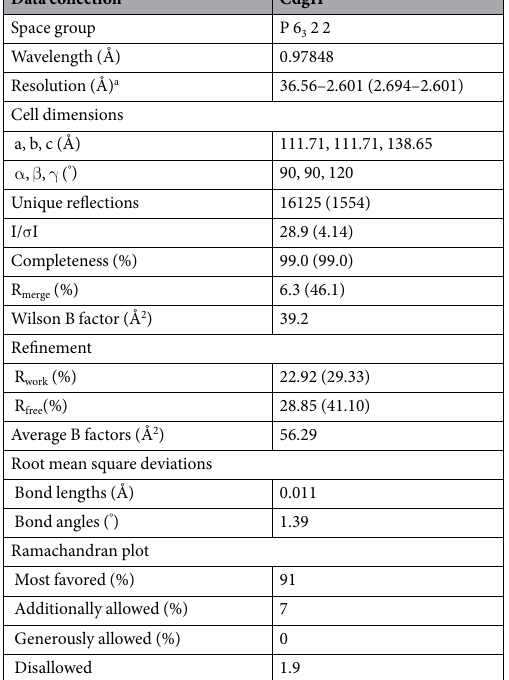
Table 1. Data-collection, phasing and refinement statistics. Note: Numbers in parentheses are for the highest resolution